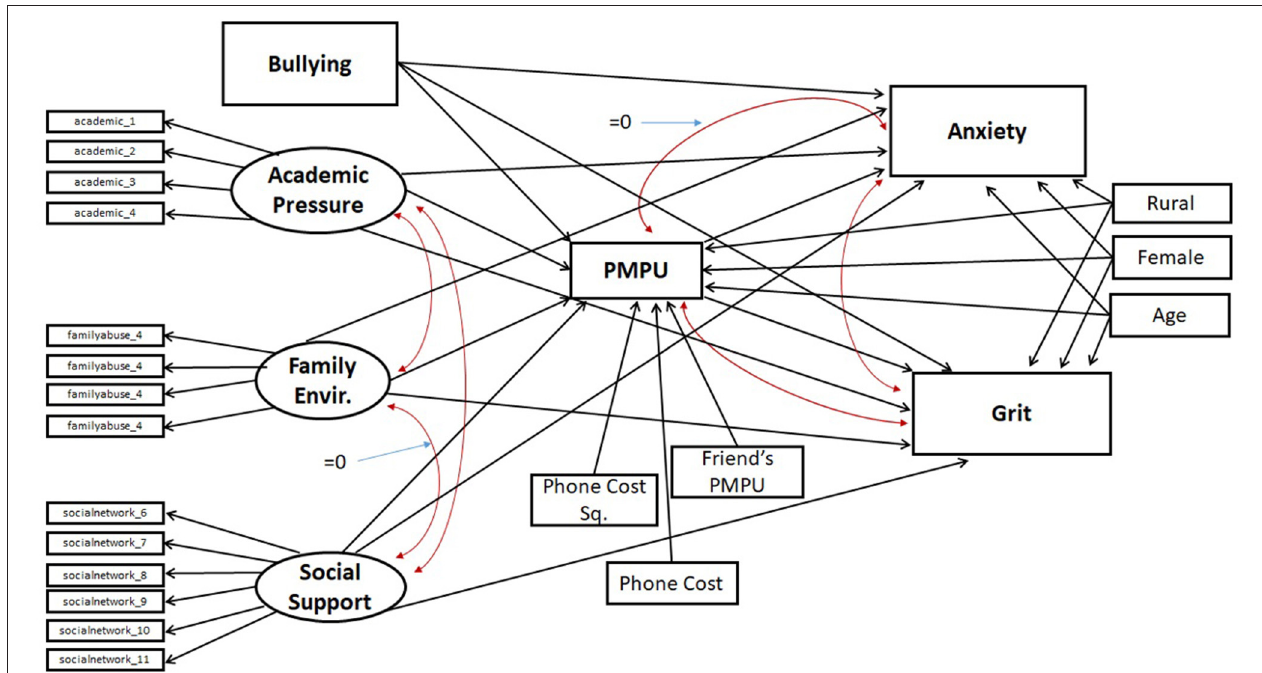
FIGURE 3 | Final structural